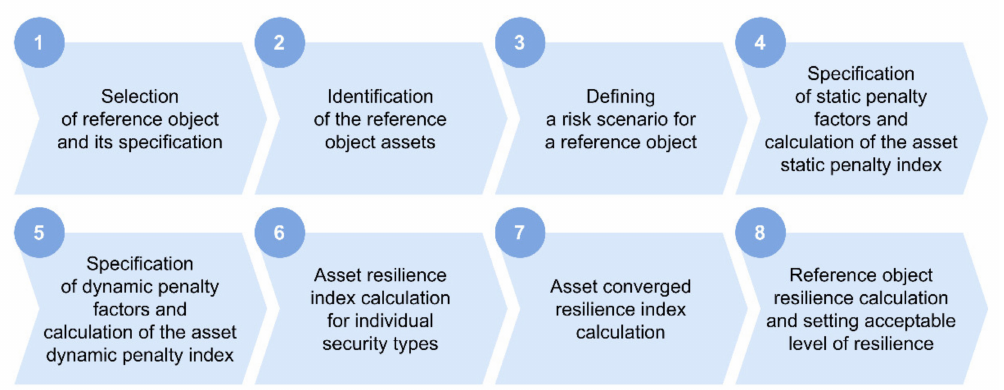
Figure 4. Procedure for Reference Object Resilience Assessment in Electricity Critical